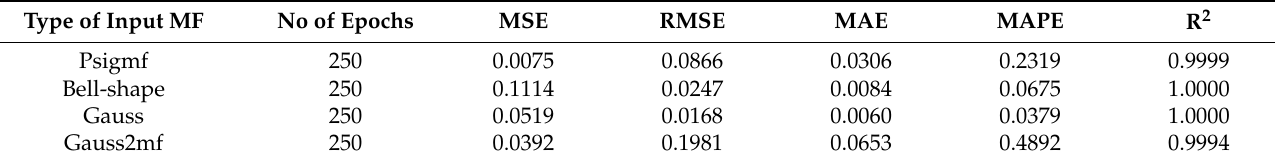
Table 7. Comparative analysis of ANFIS performance for various types of input MFs for linear MF of output.